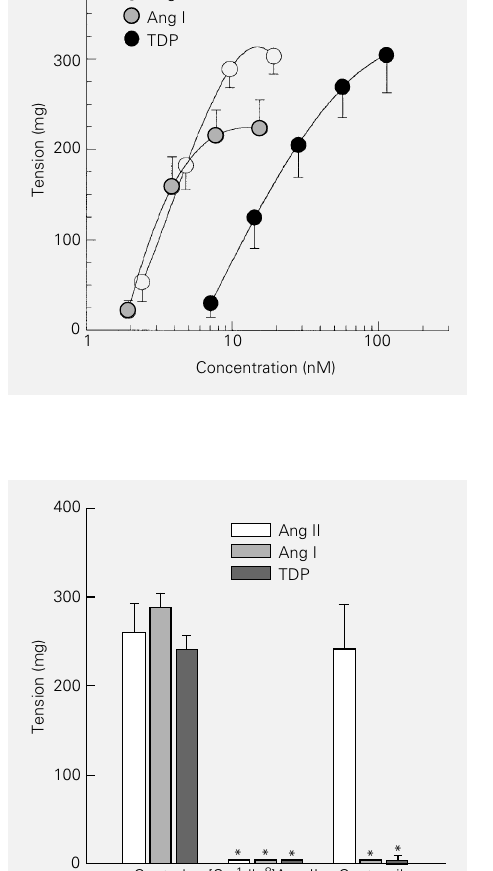
Figure 3 - Changes in perfusion pressure in the isolated rat mes- enteric arterial bed induced by bolus injections of angiotensin II (Ang II; 19 pmol), angiotensin I (Ang l; 116 pmol), tetradecapep- tide (TDP; 568 pmol) renin sub- strate and acetylcholine (Ach; 11 pmol) in intact and disrupted en- dothelium preparations in the absence (upper panel) and in the presence of 36 (cid:181)M captopril in the perfusate (lower panel). Re- sults are reported as mean – SEM and correspond to 8 and 7 observations for the upper and lower panels, respectively. *P<0.001 compared to the in- tact endothelium value (paired t - test).